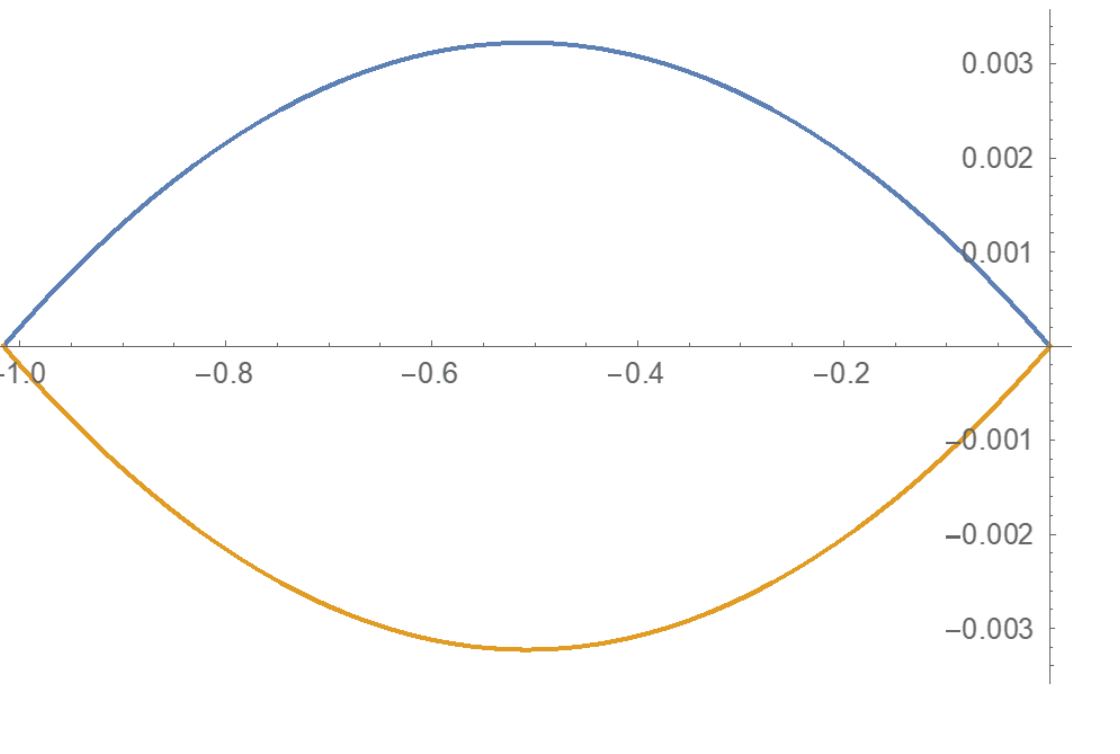
Figure 4. Cap limit domain per unit width cross-section; blue and orange curves correspond to +/ − sign in Equation